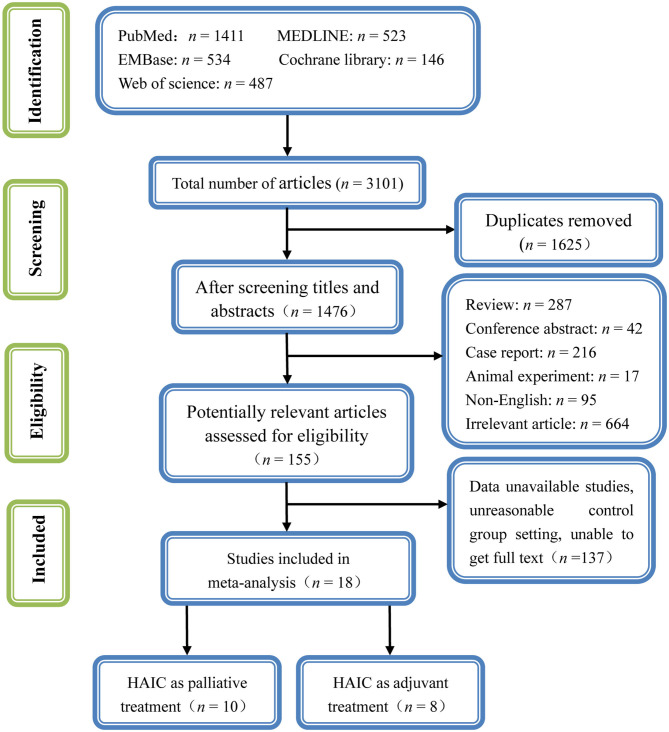
Flowchart presenting the selection process of studies.